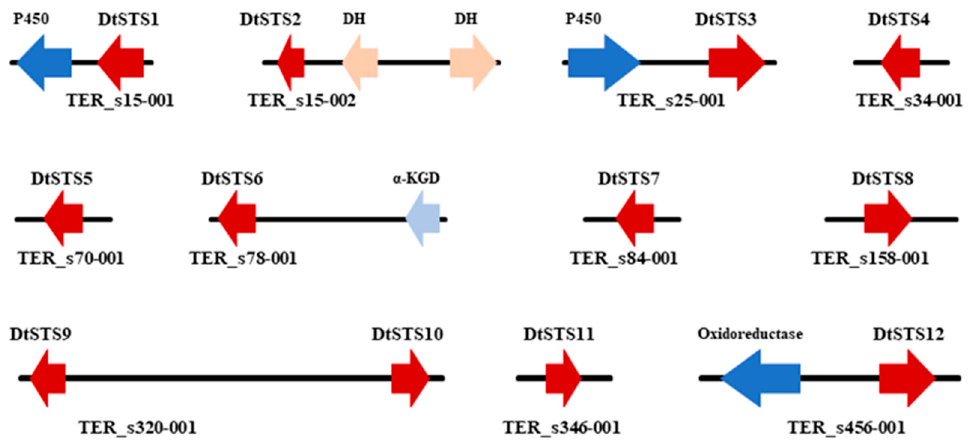
Figure 4. The genes (gene clusters) encoding sesquiterpene synthases (STSs) obtained from D . tabescens CPCC 401429. Note: sesquiterpene synthases DtSTS1-DtSTS1. DH, dehydrogenase; α -KGD, α -KG dependent dioxygenase; P450, P450 monooxygenase. The arrows represent the genes.